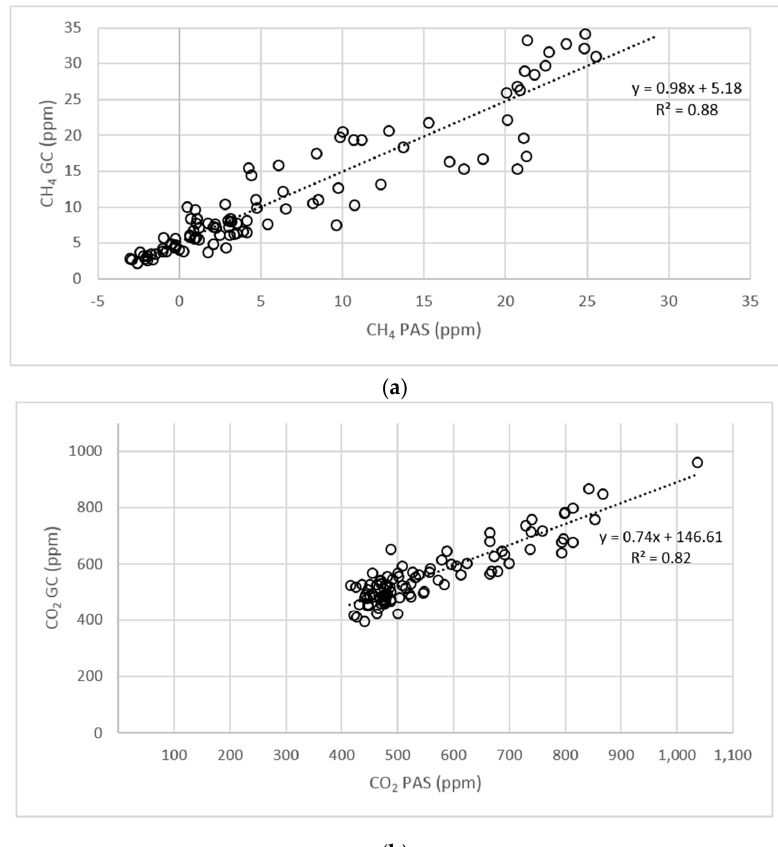
Figure 6 . Cont. Figure 6. Cont